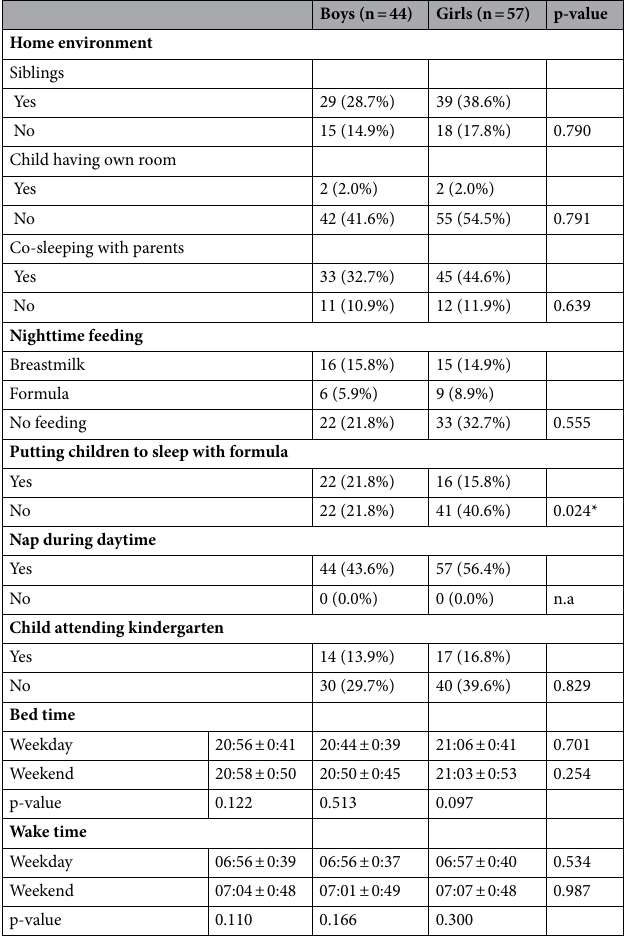
Table 2. Sleep arrangements and sleep variables by gender (number or mean ± s.d., *p < 0.05).